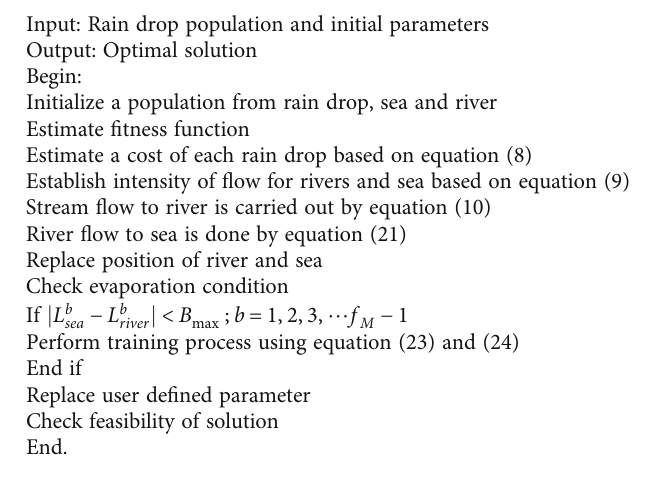
Algorithm 1: Pseudocode of the proposed